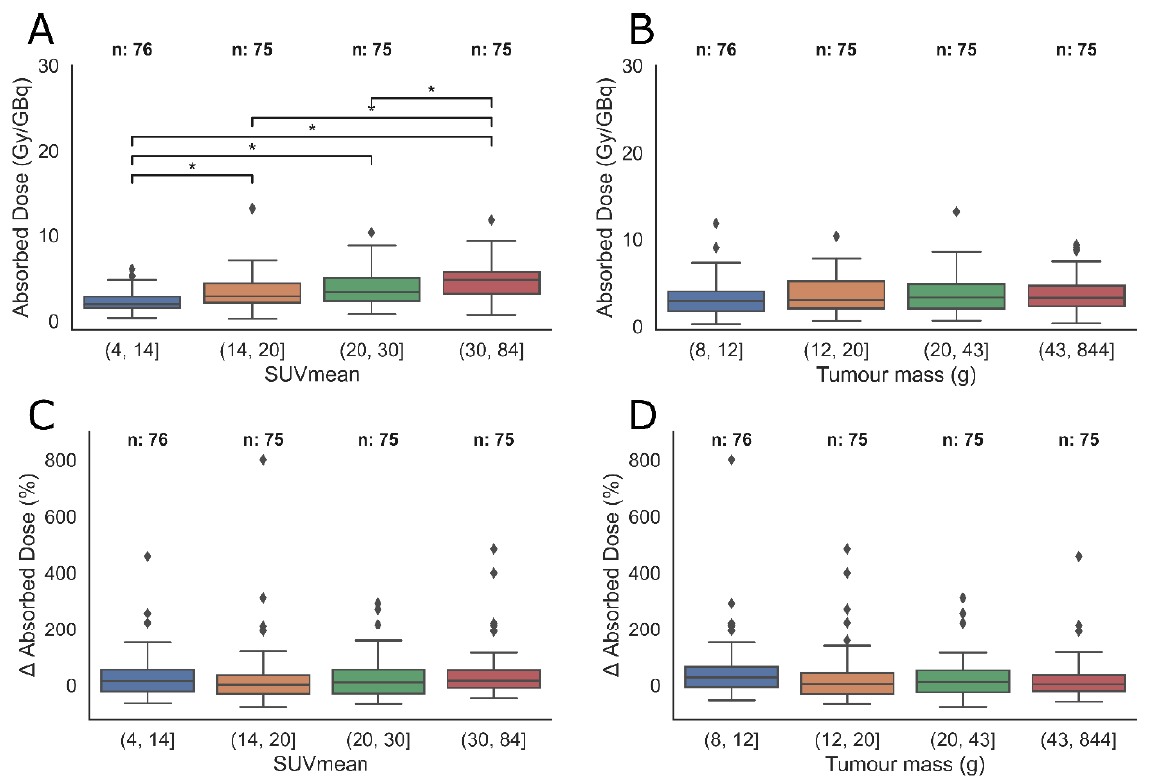
Figure 6. Differences of absorbed dose ( A , B ); and relative difference between predicted and calculated absorbed dose ( C , D ) between tumours grouped by SUV mean and tumour mass. Grouping was done by keeping group sizes equal. Stars indicate significant differences of the group means (Tukey test). Only the absorbed dose of tumours grouped by SUV mean was different between groups. A grouping based on equal ranges of mass and SUV mean -values is found in the Supplementary Materials (Supplementary Figure S3).